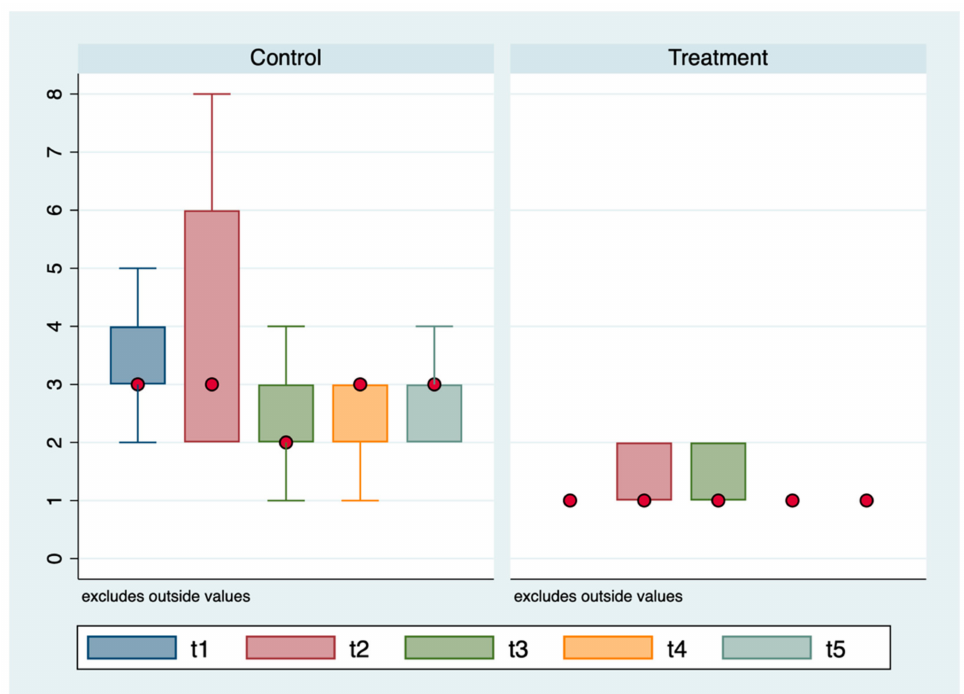
Figure 5. Glasgow CMPS-SF scale mean values according to the groups (treatment vs. control) and time of